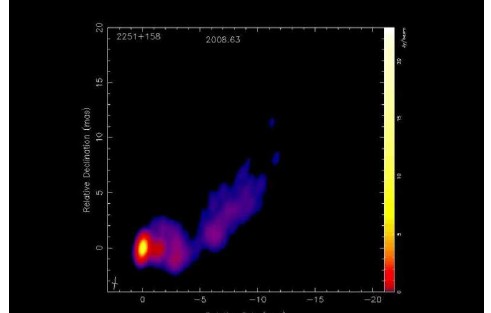
Figure 2: Figure 2: 3C454.3 shown at milliarcsecond scales for data taken from the MOJAVE VLBA cam- paign during the Bonning et al (2009) flare. A perusal of the time-dependent flare clearly shows that the jet launch from the core of the AGN is coincident with the double peaked flaring shown in the Bonning et al. re-